Question: What kind of plot is shown here?
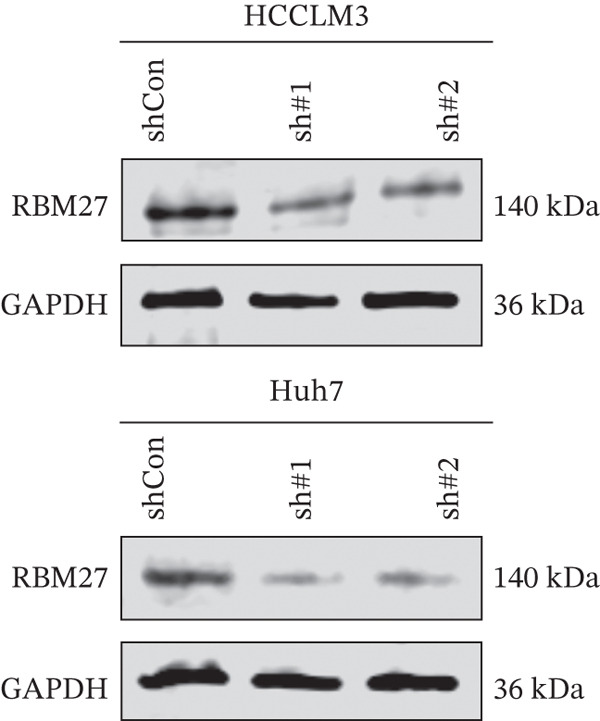
Answer: bar